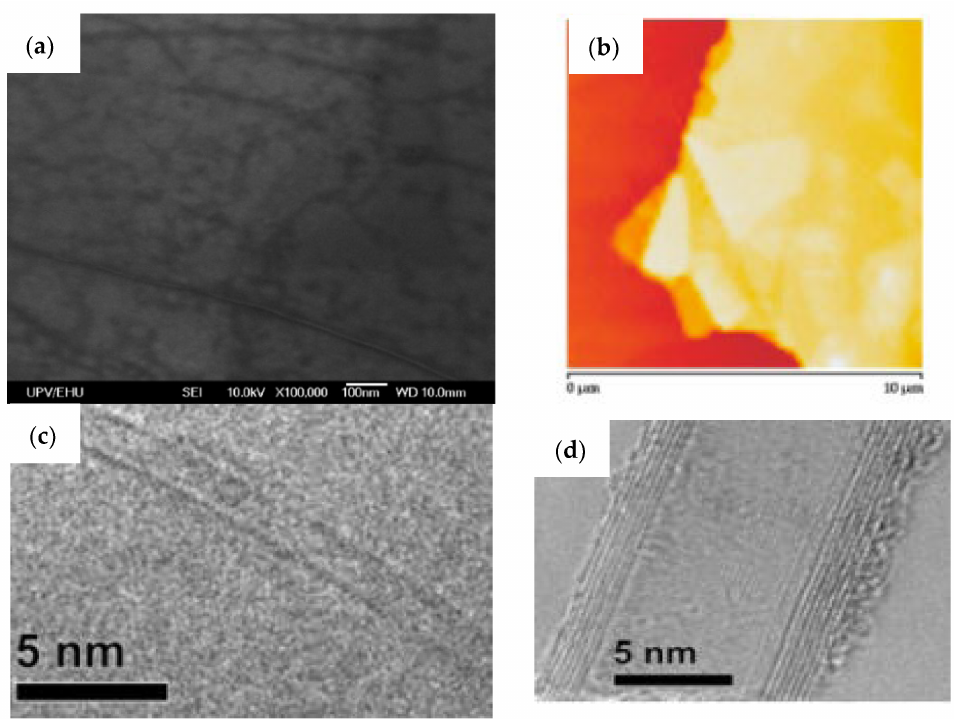
Figure 7. ( a ) Single-layer graphene’s SEM image (with 100 nm scale-bar), ( b ) many-layer graphene’s AFM image (with 10 µ m scale-bar), and TEM images of ( c ) SWCNTs and ( d ) MWCNTs. Subfigures ( c , d ) have been adapted from [119] with permission from John Wiley and Sons. Subfigure ( b ) has been adapted from [118] with permission from MDPI. (SEM and AFM experiments in subfigure ( a , b ) are performed in Universidad del Pais Vasco/Euskal Herriko Unibertsitatea—UPV/EHU laboratories, Bilbao,